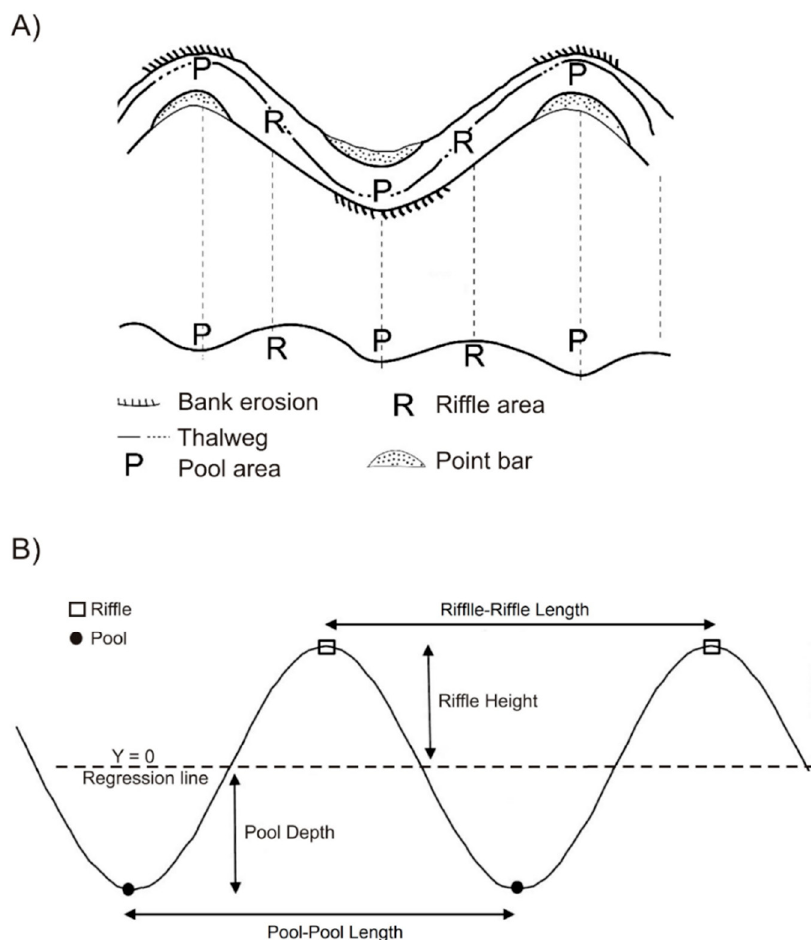
Figure 2. ( A ) The diagram of riffle–pool sequence and planform morphology of a meandering river channel (modified from Keller and Melhorn [27]). ( B ) Definition of bed-form parameters, including the lengths of riffle–riffle or pool–pool, and how the regression line is used to estimate riffle height or pool depth.